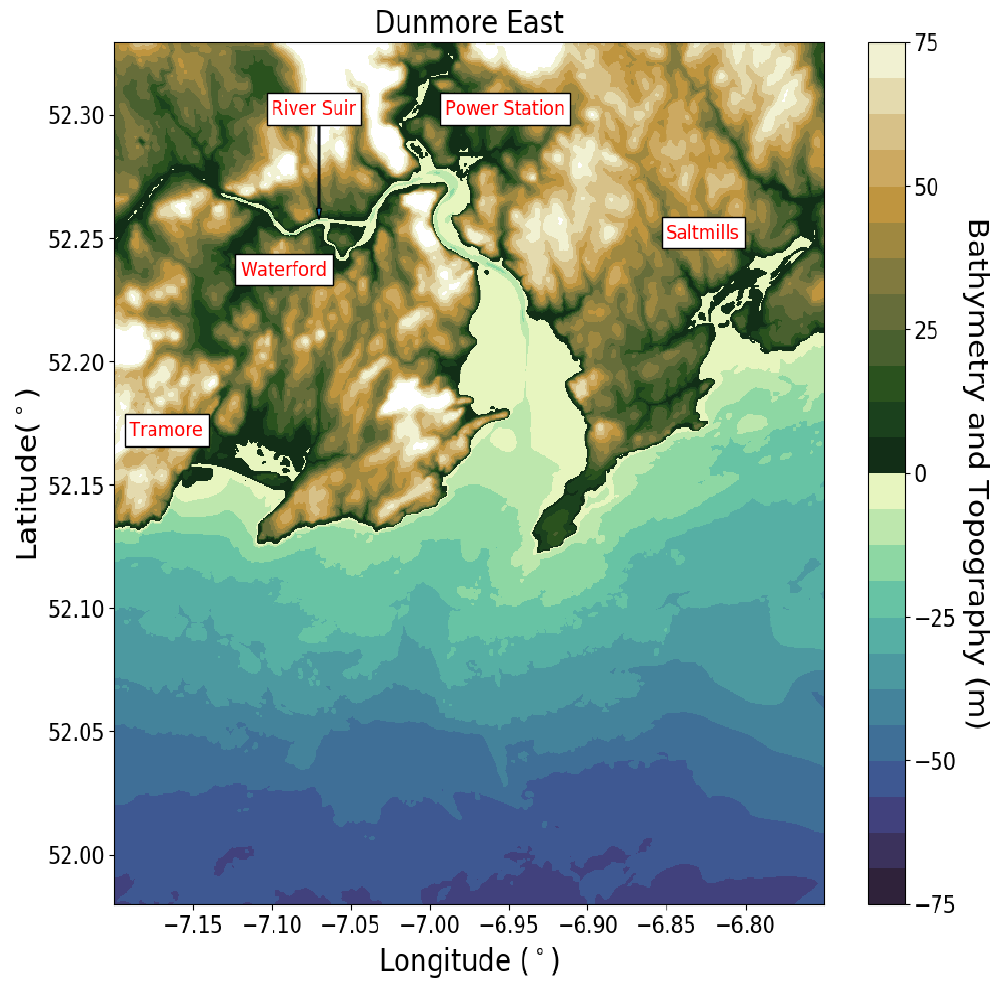
Figure 12. High resolution bathymetry and topography of Dunmore East, with key places